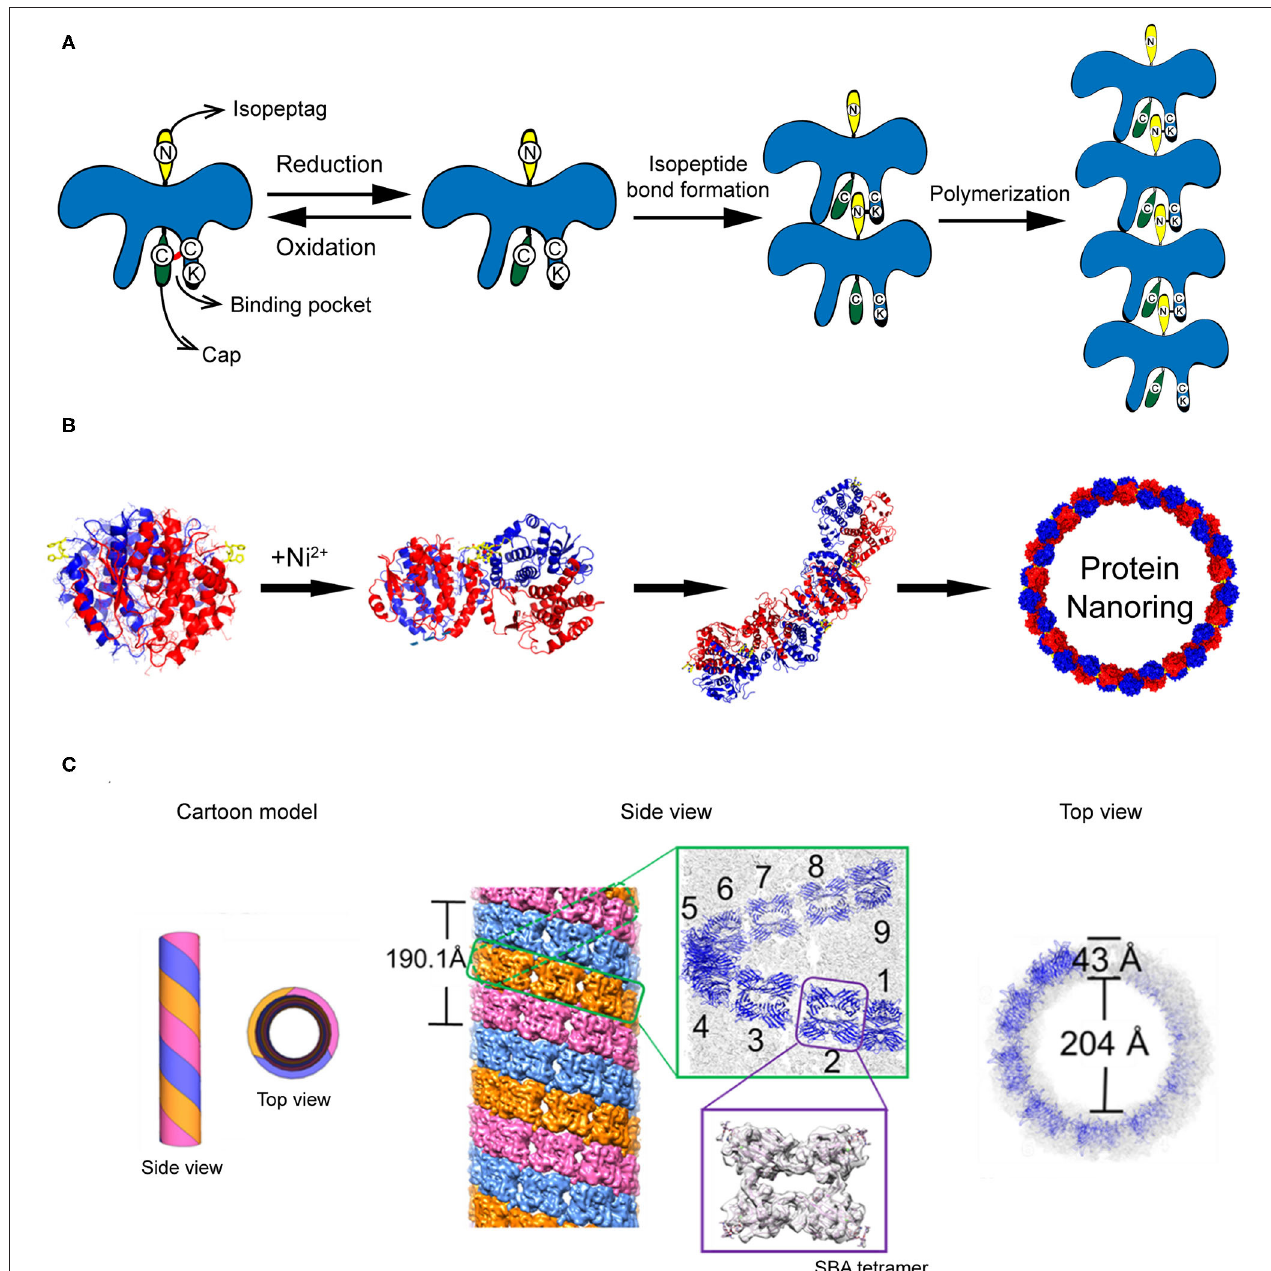
FIGURE 4 | Self-assembled 1D protein structures. (A) The nanochain formation based on the assembly of recombinant PS proteins. (B) The nanoring formed by Ni 2 + -His coordination. Reproduced with permission from Bai et al. (2013). Copyright 2013 American Chemical Society. (C) The formation of microtubule structure driven by glycoprotein recognition and Rhodamine B dimerization. Reproduced with permission from Yang et al. (2016). Copyright 2016 American Chemical Society. from different directions are needed to achieve the